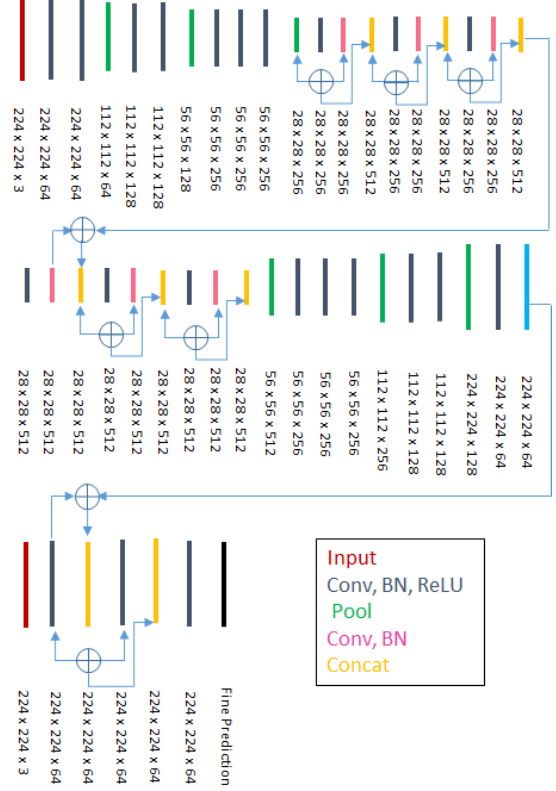
Figure 2. The proposed MS-CDN for height prediction